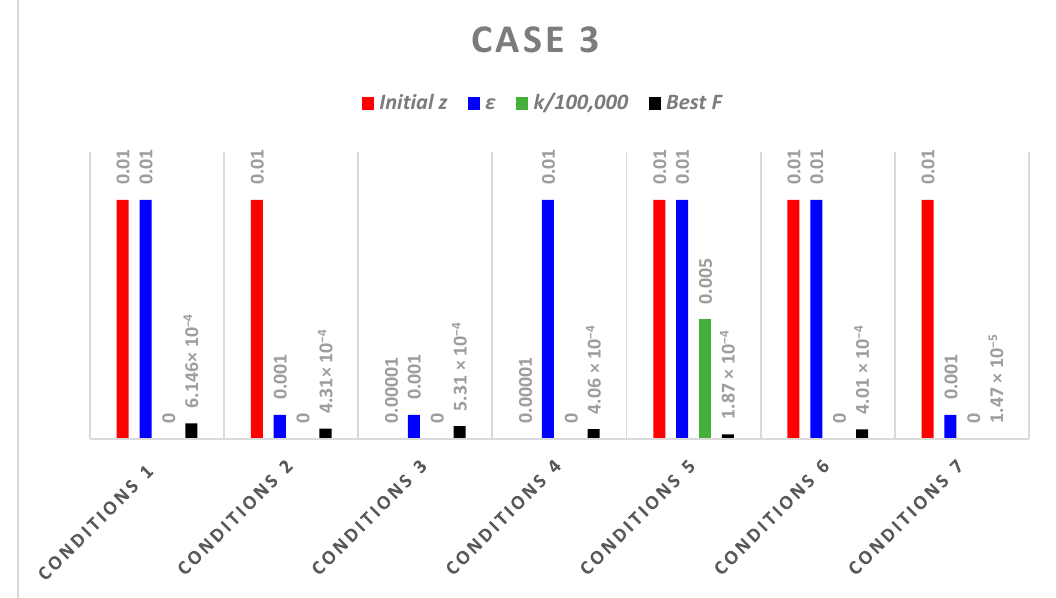
Figure 7. Graphical presentation of Table 6.